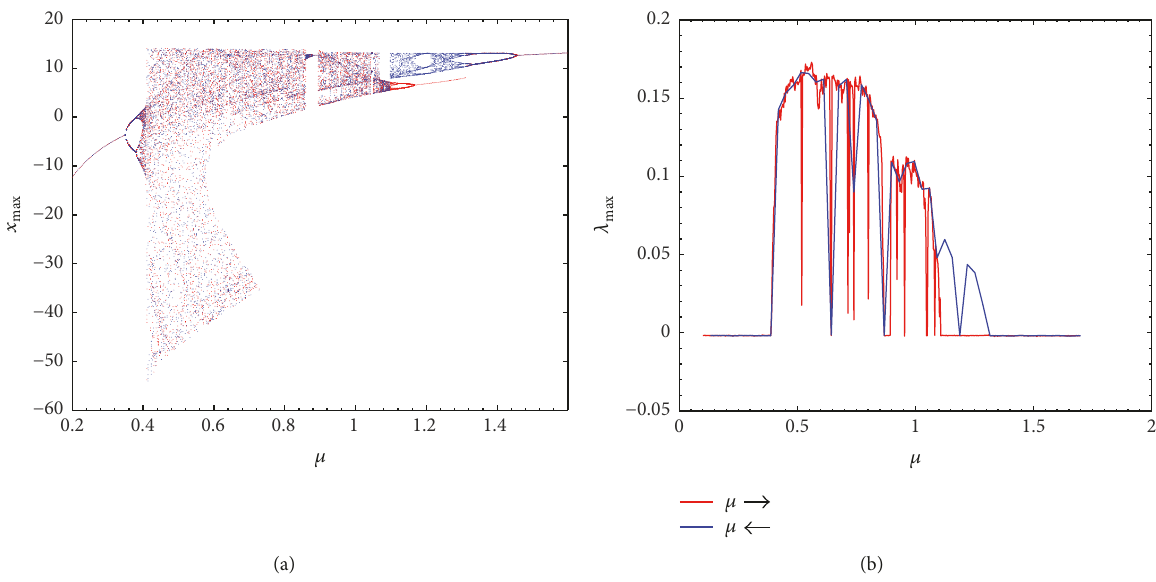
Figure 2: Bifurcation diagrams (a) showing local maxima of the coordinate 𝑥(𝜏) versus 𝜇 of the jerk attractor in two directions (red dot indicates first direction from down to up and the blue dot indicates the second direction from up to down) and the corresponding graphs (b) of 1D largest numerical Lyapunov ( 𝜆 max ) exponent plotted in the range 0.1 ≤ 𝜇 ≤ 1.7 . A positive exponent ( 𝜆 max > 0 ) indicates chaos, while regular states are characterized with negative values of Lyapunov exponent ( 𝜆 max < 0